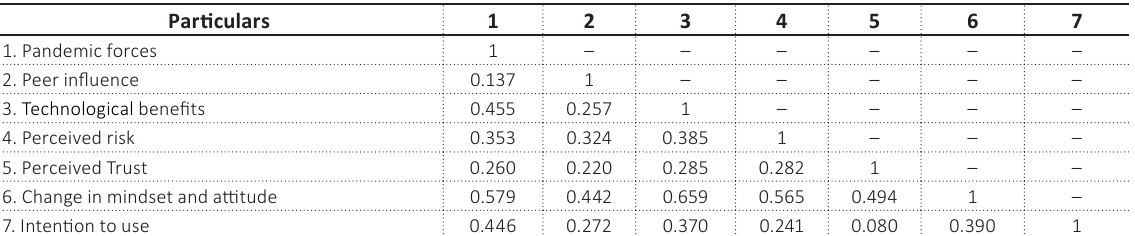
Table 8. Correlation among the core variables – Kendall’s Tau